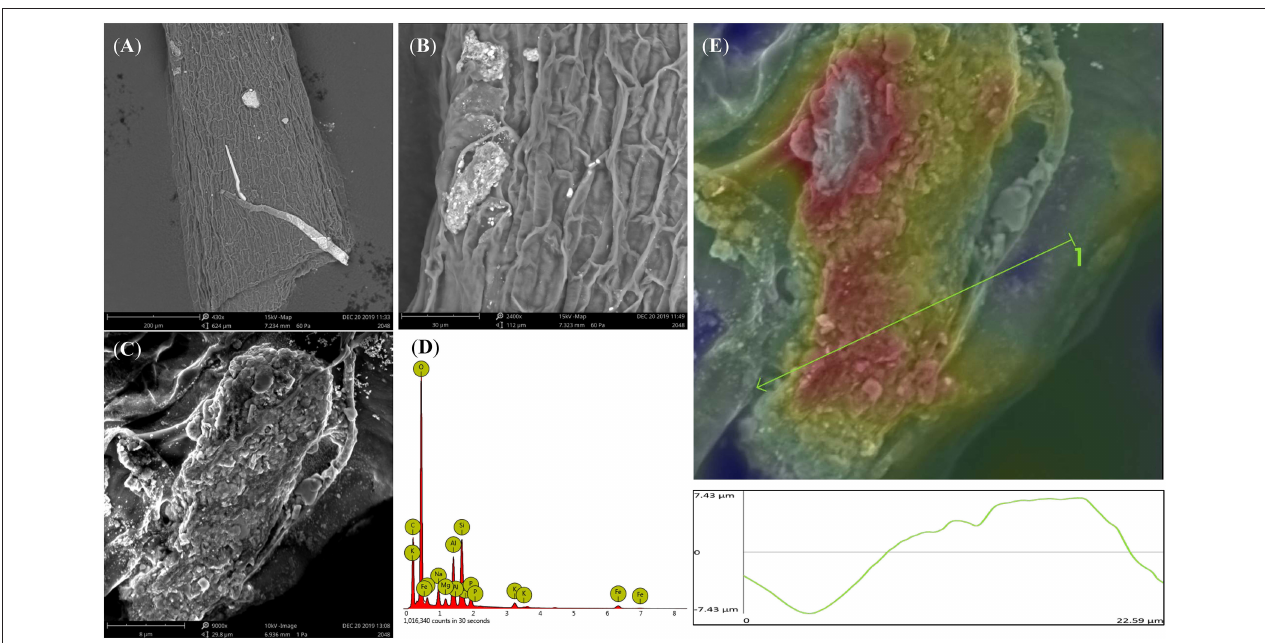
FIGURE 6 | Back scattered electron images of rice root from 0.1% BCE treatment showing micron- and sub-micron-sized particles ( A , × 400; B , × 2,000; C , × 9,000) attached to the roots. EDS image of the adhered biochar particle containing minerals and nutrients (D) . 3D imaging and profile measurement of the particle in (C) . Red color indicates top three microns of the particle (E)